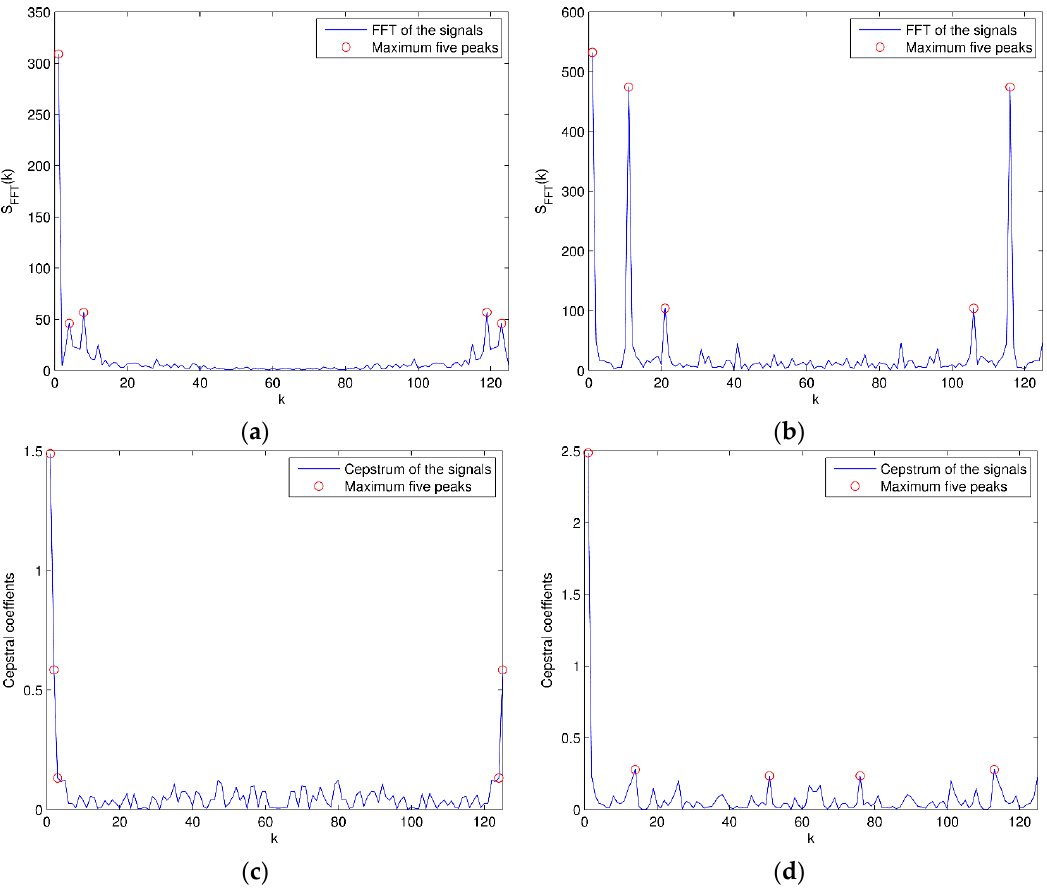
Figure 5. FFT and cepstrum: ( a ) FFT of the signals for walking in a parking lot; ( b ) FFT of the signals for jumping (the maximum five FFT peaks are marked with “O”); ( c ) Cepstrum of the signals for walking in a parking lot; ( d ) Cepstrum of the signals for jumping (the maximum five cepstrum peaks are marked with “O”).